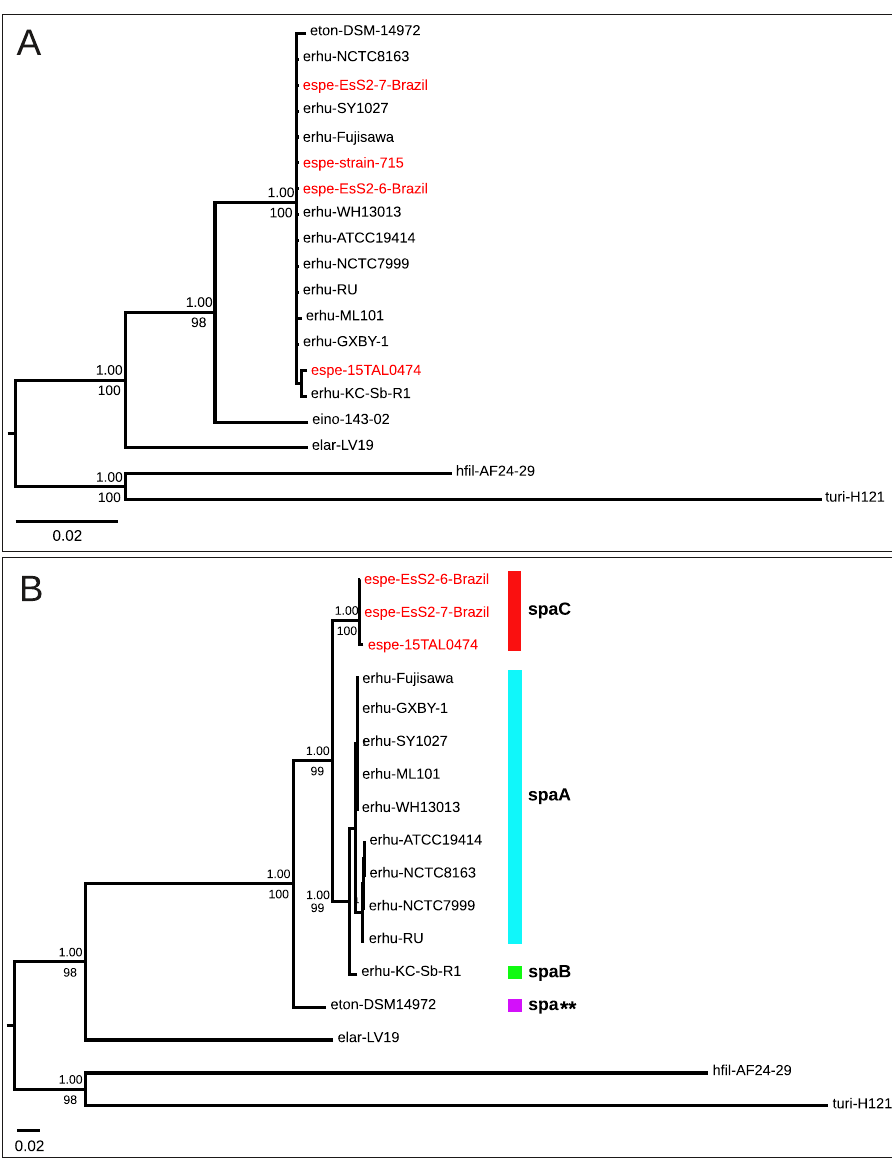
Figure 1. Phylogenetic reconstruction of Erysipelothrix genus using single-genes. Legend: ( A ) Bayesian phylogenetic tree based on 16S rRNA gene under the model GTR+I+G. ( B ) Bayesian phylogenetic tree based on rpoB nucleotide sequence under the model GTR+I+G. Posterior probability values of support obtained in Bayesian Analysis (BA) are shown above nodes. Rapid bootstrap values obtained in Maximum Likelihood (ML) analysis are shown below nodes. Species were indicated as follows: E. sp. Strain 2 isolates (espe-EsS2-6-Brazil, espe-EsS2-7-Brazil, espe-15TAL0474, espe-strain-715); Erysipelothrix rhusiopathiae isolates (erhu-ATCC19414, erhu-KC-Sb-R1, erhu-NCTC8163, erhu-NCTC7999, erhu-SY1027, erhu-GXBY-1, erhu-WH13013, erhu- Fujisawa, erhu-ML101, erhu-RU); Erysipelothrix inopinata strain 143-02 (eino-143-02); E. tonsillarum DSM 14972 (eton-DSM14972); E. larvae LV19 (elar-LV19); Holdemania filiformis AF24-29 (hfil-AF24-29); Turicibacter sp. H121 (turi-H121). Species hfil-AF24-29 and turi-H121 were used as outgroups. E. sp. Strain 2 isolates are shown in